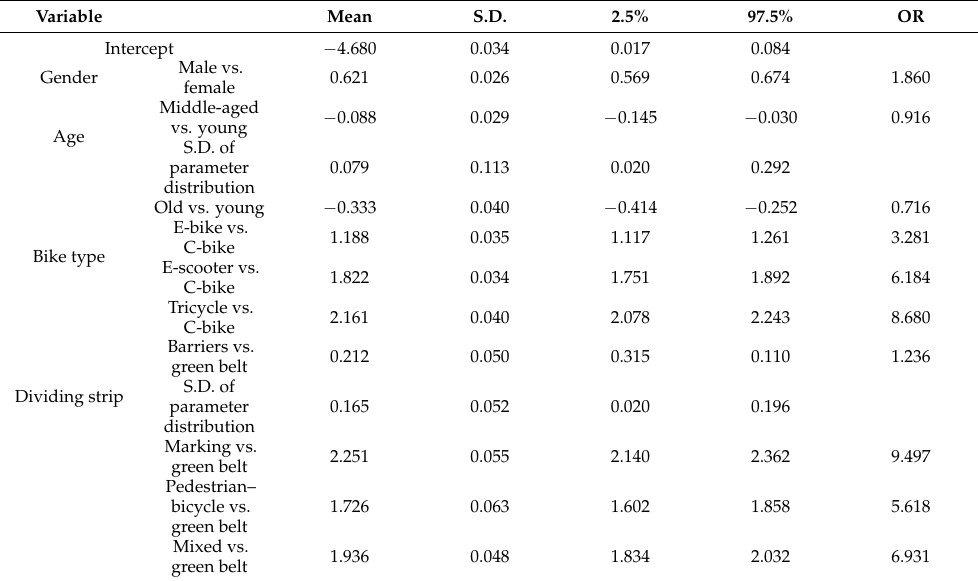
Table 4. Estimation from the Bayesian random parameters logit